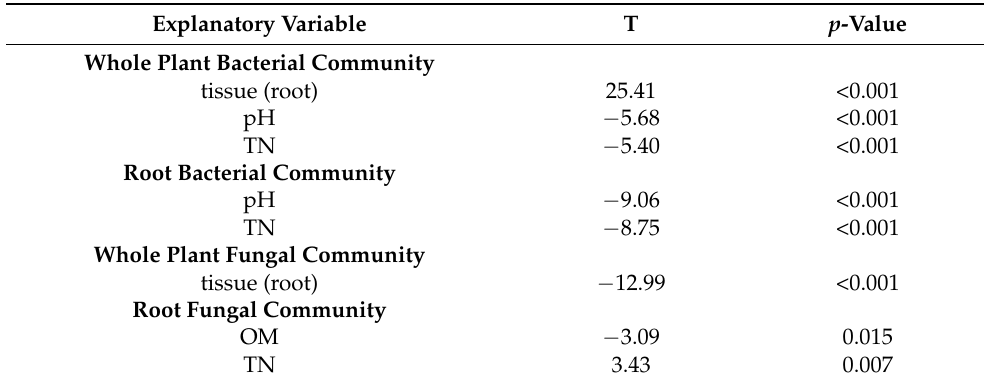
Table 3. Multiple stepwise regression model results for genus (for bacteria) or species (for fungi) richness that significantly correlated with tissue type or environmental factors (TN: total nitrogen; OM: organic matter).